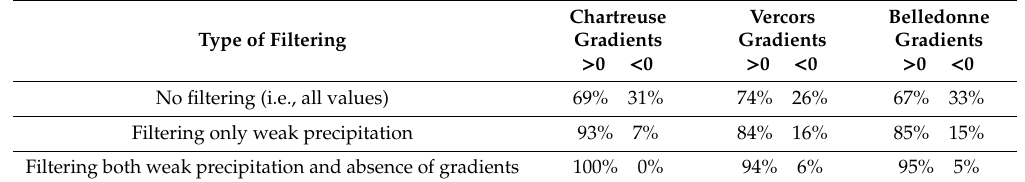
Table 2. Rate of positive or negative daily gradients, in function of the filtering. Type of Filtering